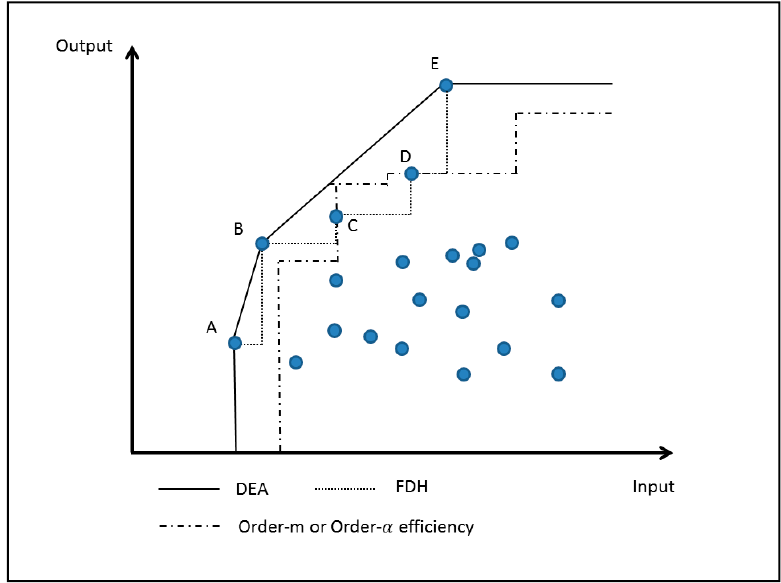
Figure 1. Graphical exposition of full and partial frontier efficiency analysis.